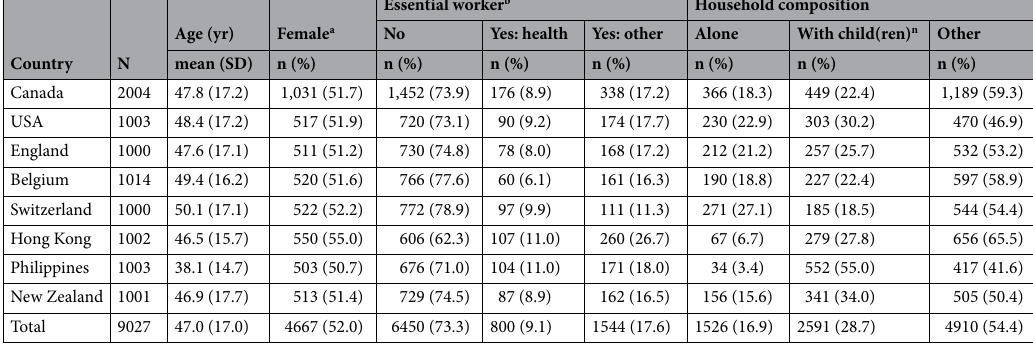
Table 1. Sample numbers and weighted distribution of respondents’ demographic characteristics, overall and partitioned by country. a 42 (0.5%) respondents did not identify as being male or female; b 234 (2.6%) did not know or declined to answer.